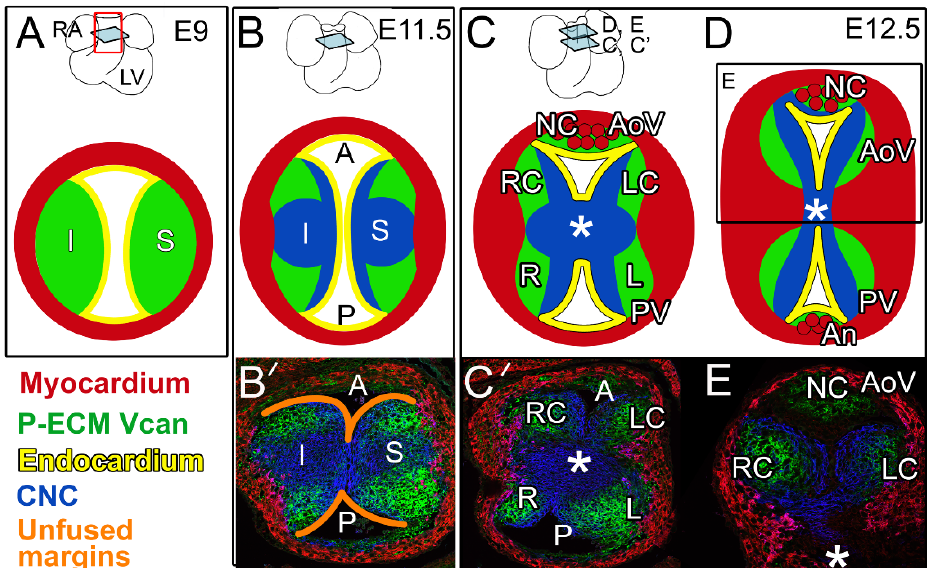
Figure 1. Provisional extracellular matrix (P-ECM, green) is downregulated during OFT remodeling and exhibits a complementary pattern to cardiac neural crest (blue). Sections of remodeling OFT shown for embryonic day 9 (E9) in panel ( A ), E11.5 in panels ( B , B’ ), and E12.5 in panels ( C , C’ , D , E ). Whole hearts are shown on the top row in panels ( A – D ). Light blue squares on the whole heart schematics indicate the relative position of the OFT cross-sections in each panel: RA—right atrium, LV—left ventricle; red rectangular outline in A indicates OFT region of the heart. Schematics of cross-sections depicting the remodeling OFT ( A – D ): Red—myocardium; yellow—endocardium; green—versican (Vcan) indicative of P-ECM; S—superior cushion; I—inferior cushion; orange outlines ( B’ )—unfused margins of the S and I fused cushions; A—aortic channel; P—pulmonic channel; L, LC—left and left coronary cusps of the pulmonary valve (PV) and aortic valve (AoV), respectively; R, RC—right and right coronary cusps of the PV and AoV, respectively; NC—non-coronary cusp of the AoV; An—anterior cusp of the PV; *—aorticopulmonary septum; red circles ( C , D ) denote myocardial lineage of Tnnt2-Cre origin of the NC and An cusps. Immunolocalization of OFT cross-sections ( B’ , C’ , E ); blue-Wnt1-Cre; EGFP indicates CNC lineage, green—intact Vcan, red—myocardium (smooth muscle